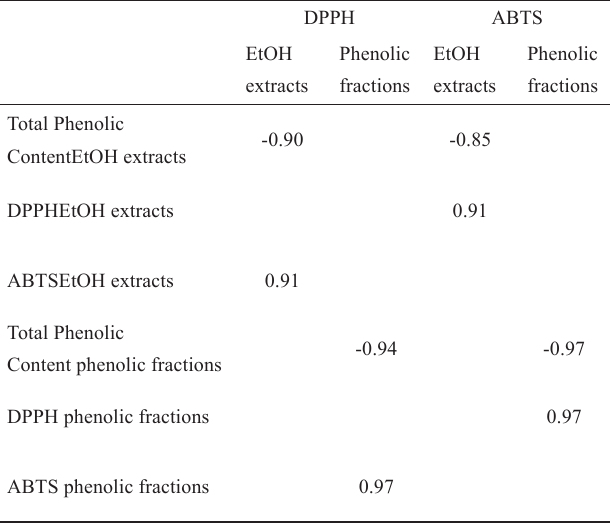
Table 3. Pearson correlation coefficients between the total phenolic content and the antiradical activity DPPH and